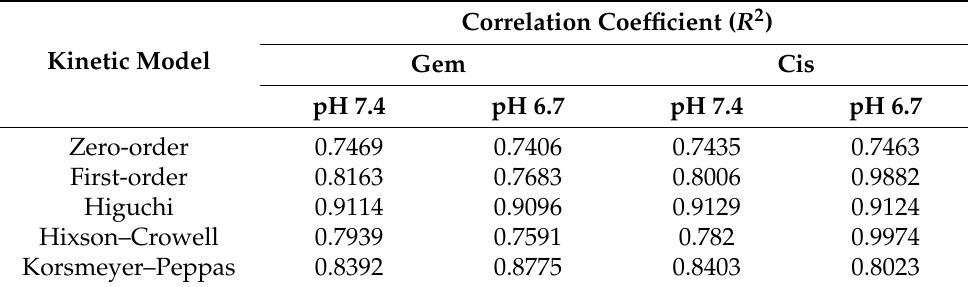
Table 7. The correlation coefficient ( R 2 ) for different models of mechanisms of drug release at different pH of SLF.